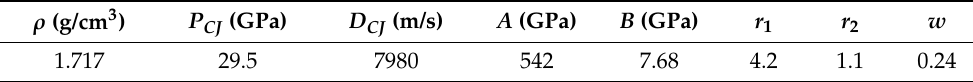
Table 2. Properties and parameters of explosive